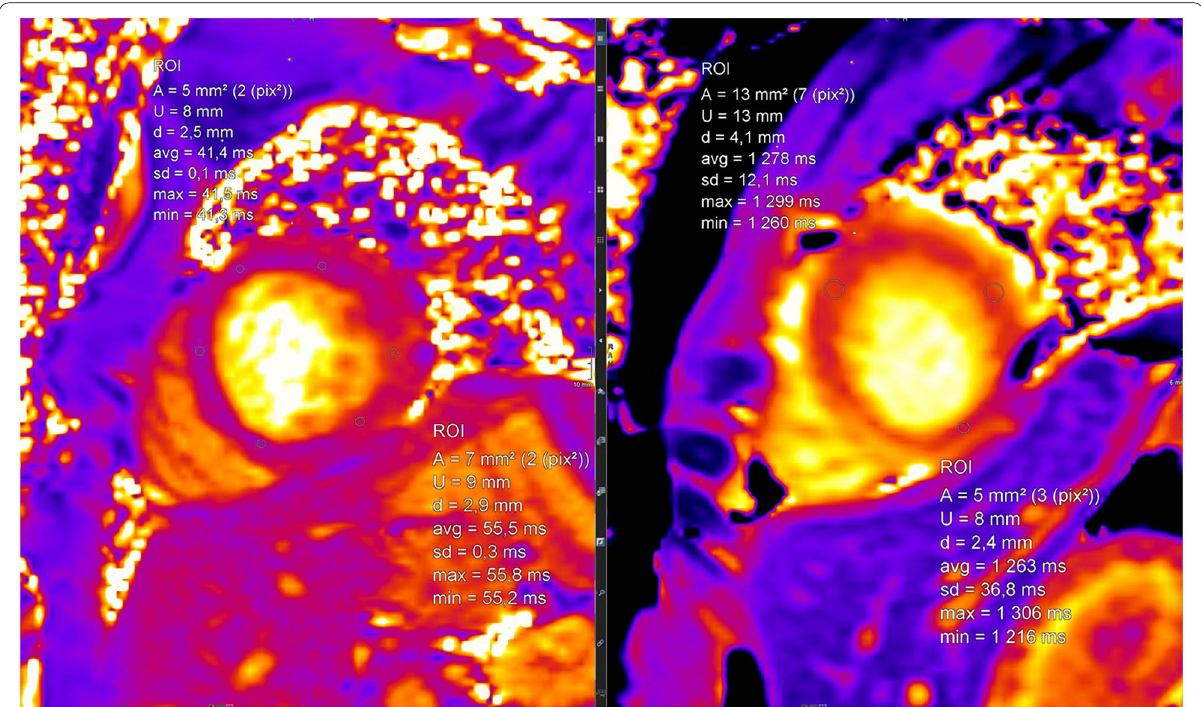
Fig. 15 (Mapping): T2 map (left) anteroseptally 37–40 ms; inferolaterally 49–56 ms, T1 map prä KM (right) anteroseptally 1278 ms; inferolaterally 1263 ms. The color maps allow a rapid assessment of edema and inflammation/fibrosis plus the quantification (in regions, which are conspicuous in LGE and/or maps)